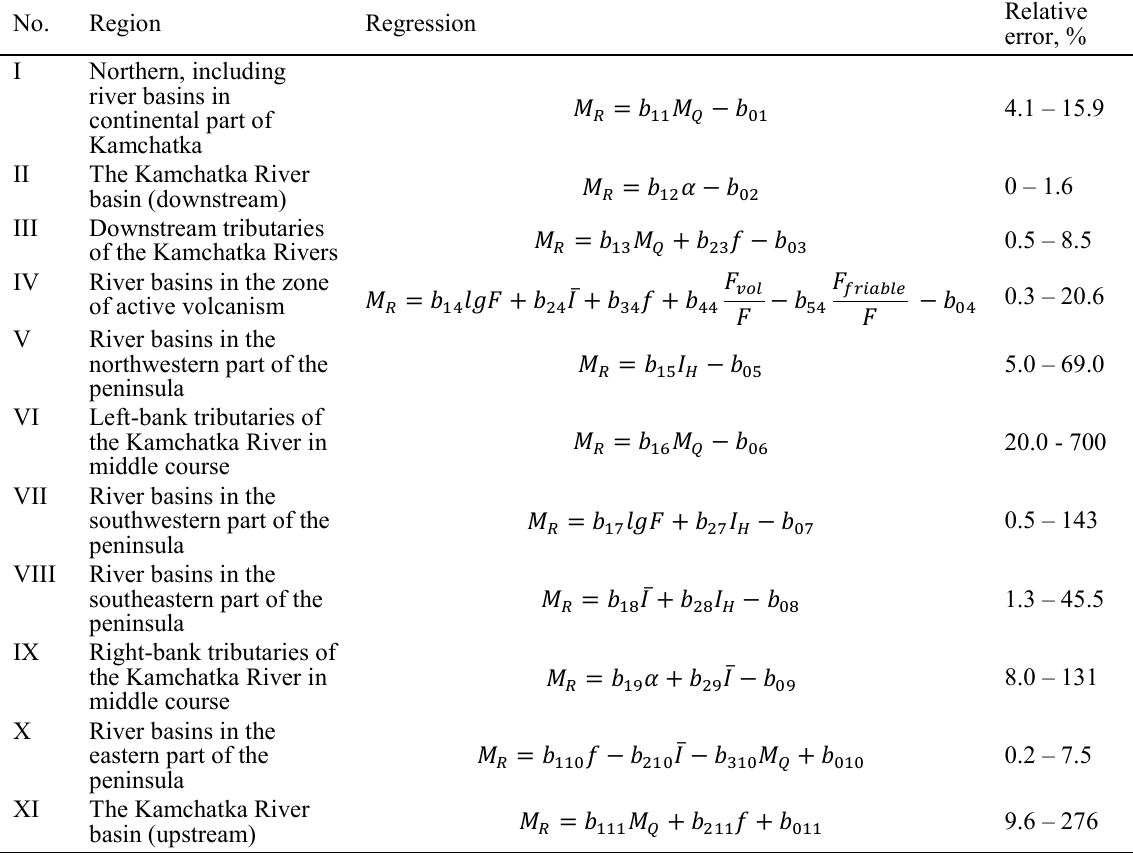
Table 1 Multiple regression equations (2) for erosive regions in the Kamchatka Krai. See equation (2) for description of variables. No. Region Regression